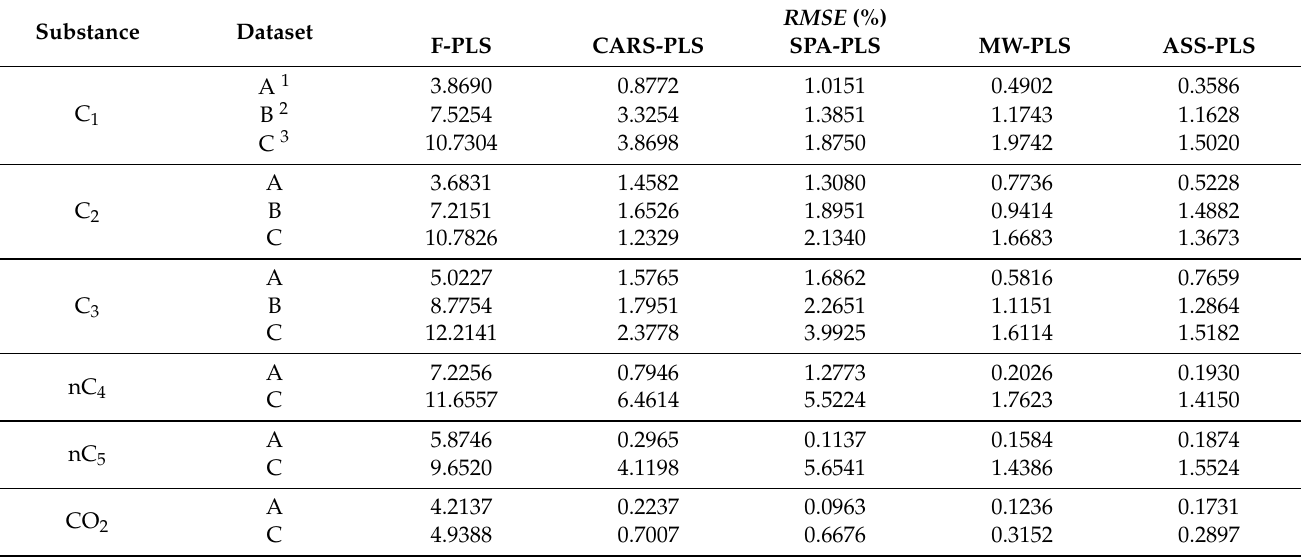
Table 2. Comparison of the effects of five different analysis methods in three types of datasets.